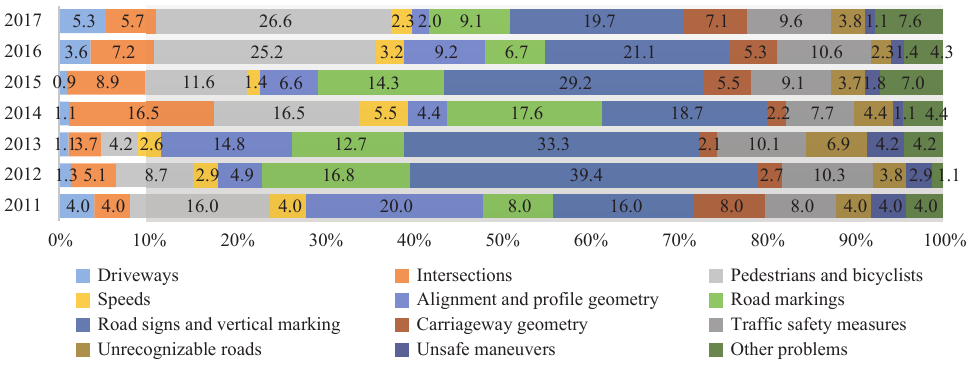
Figure 4. The occurrence frequency of each problem category for all Road Safety Audit object